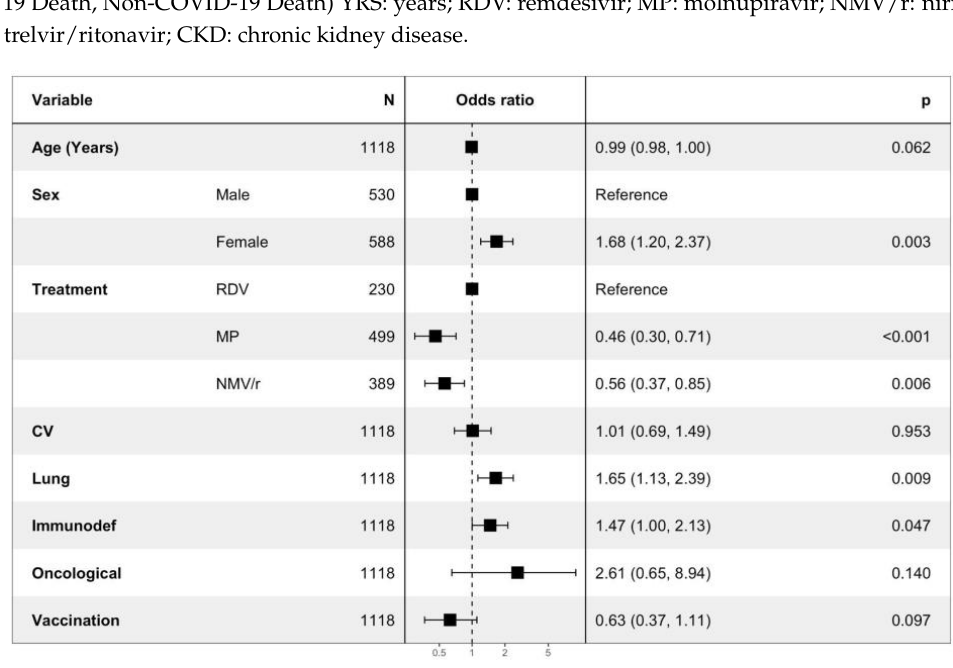
Figure 4. Linear regression analysis of time to negativization . RDV: remdesivir; MP: molnupiravir; NMV/r: nirmatrelvir/ritonavir; CV: cardiovascular disease; Immunodef: immunodeficiency. 3.3. Adverse Effects Although no severe adverse effects, according to the EMA definition [20], were re- ported in the three groups of treatment, RDV showed the fewest number of events (14.8%); MP and NMV/r, on the other hand, showed a number of events in 22.5% and 54% of cases, respectively (Figure 5), mainly diarrhea and metallic taste (Figure 6). Only 13 patients voluntarily interrupted early treatment with antiviral drugs: five patients treated